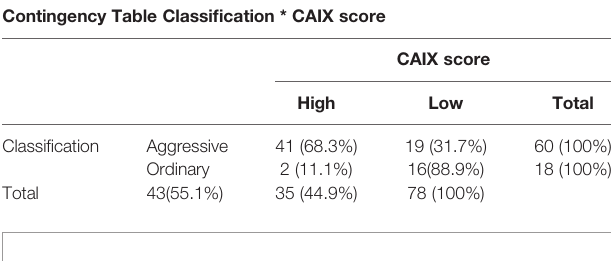
Figure 1B : difference between CAIX HIGH and LOW curves is signi fi cant as resulted from Log-Rank test (p = 0.05). Taken together our results show that the higher CAIX expression signi fi cantly correlates with BCC aggressive behavior.